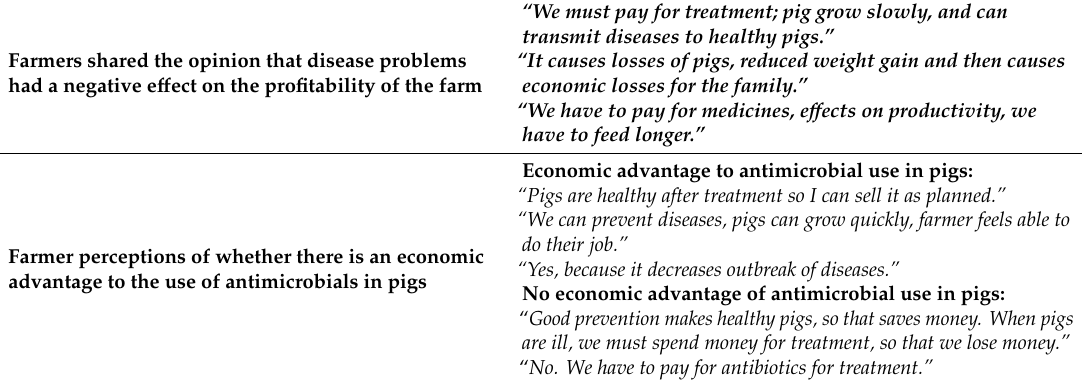
Table 2. Farmer perceptions of the economics of disease and antimicrobial